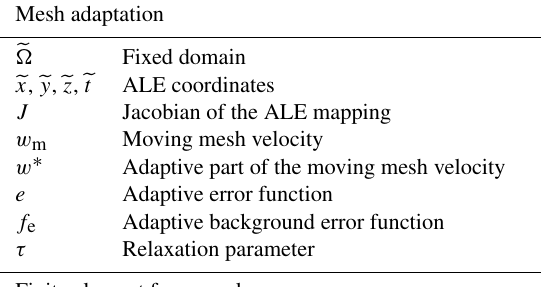
Table 2. Mesh adaptation and finite element specific variables de- fined in this paper.